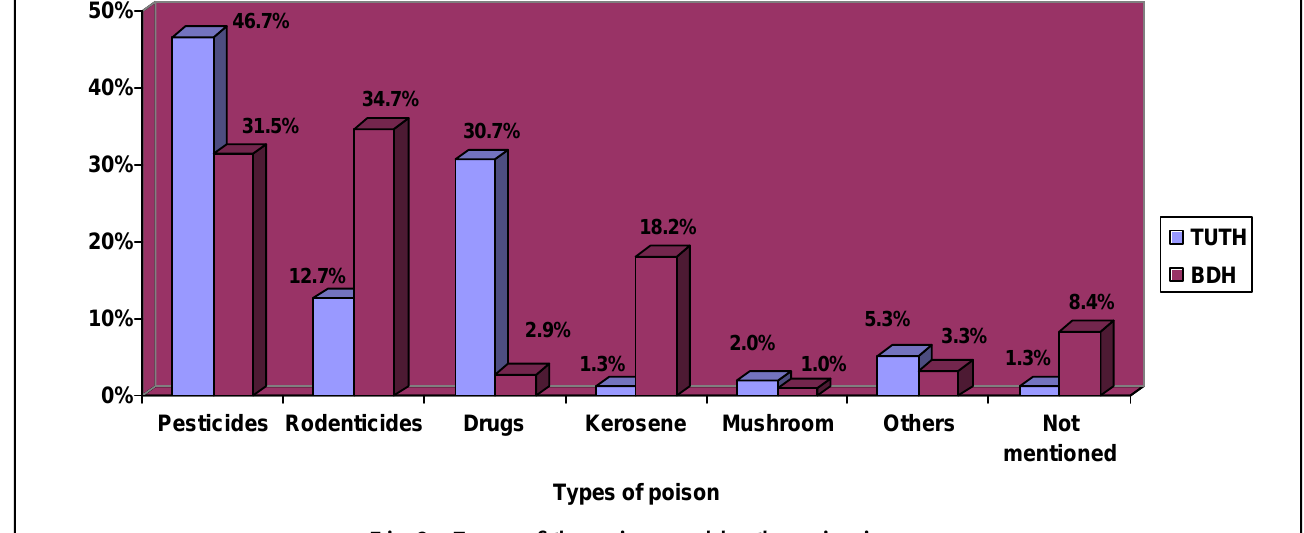
Fig. 3 : Types of the poison used by the poisoning